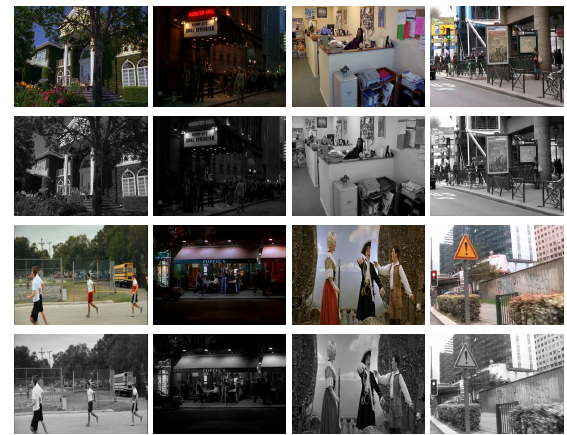
Figure 1 . Example frames in color (first and third rows) and grayscale (second and fourth rows). The columns from left to right correspond to the categories daylight outdoor, night light outdoor, indoor, and urban road. Initially, the videos were in different compressed formats. We converted all videos to uncompressed AVI format.